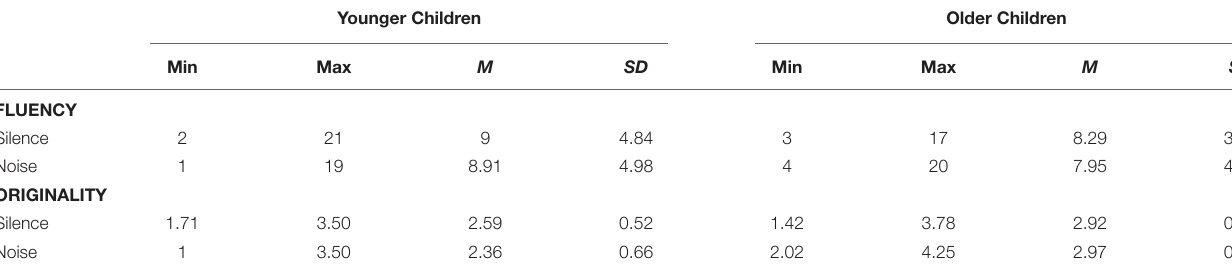
TABLE 3 | Scores at the AUT for the younger and older children, in silence and noise. Younger Children Older Children